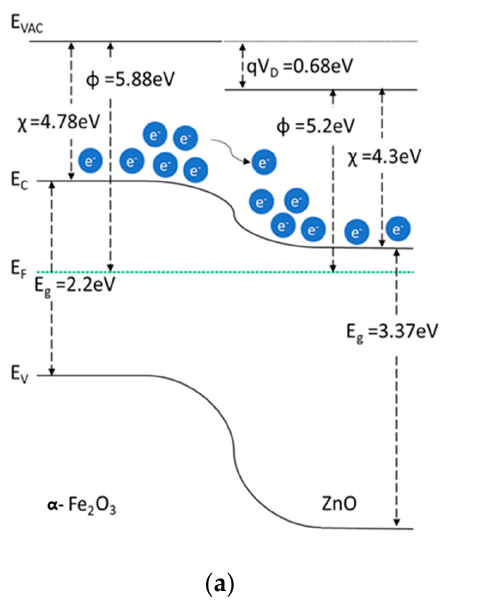
Figure 4. Schematics of ZnO nanowire (NW) vines decorated with α -Fe 2 O 3 .